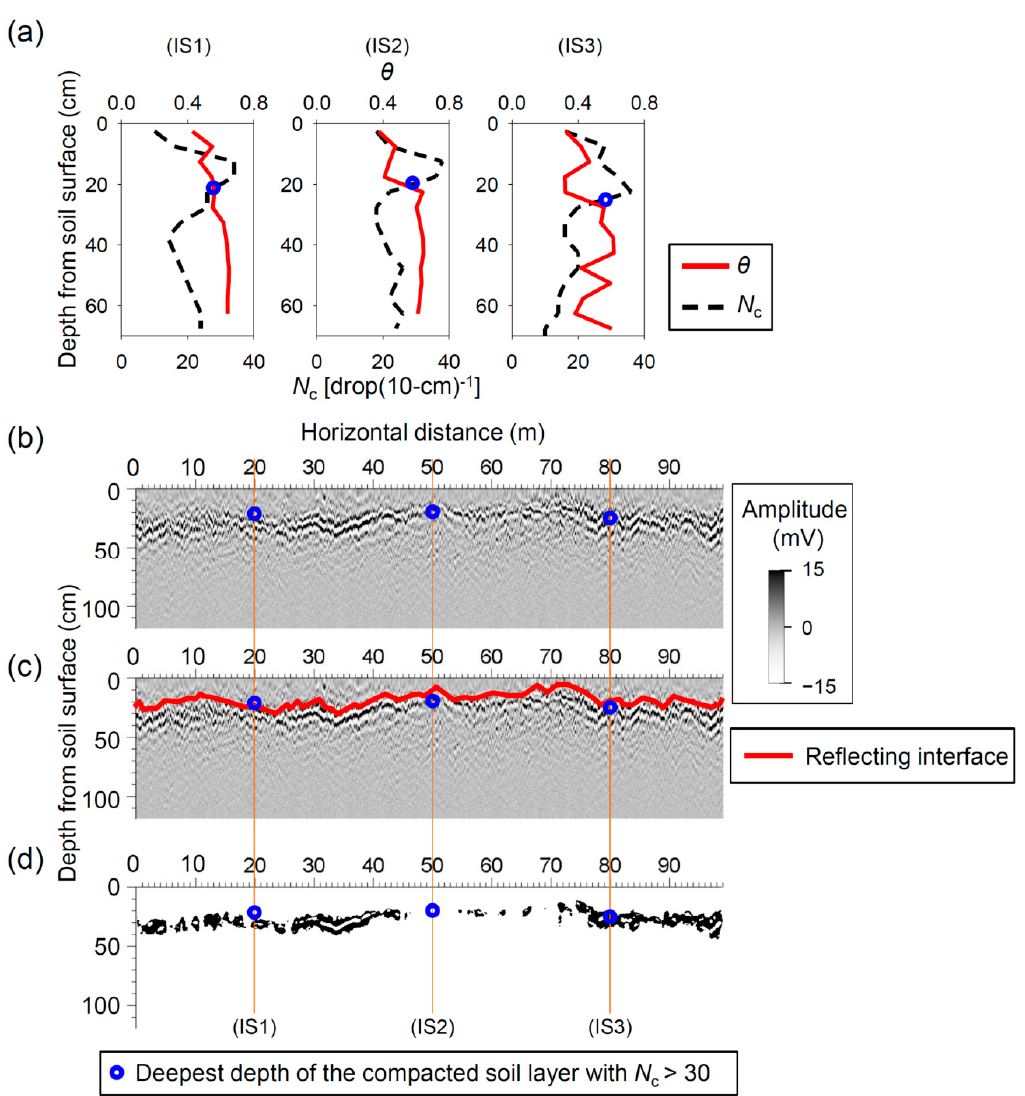
Figure 7. ( a ) Vertical profiles of θ and N C measured by the CPMP, ( b ) radargram, ( c ) radargram with interpretation of the reflecting interface, and ( d ) the area in which the median amplitude within a radius of five pixels was > 15 mV in the radargram at the IS site.